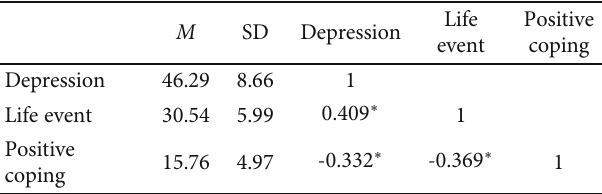
Table 2: Related studies on depression and life